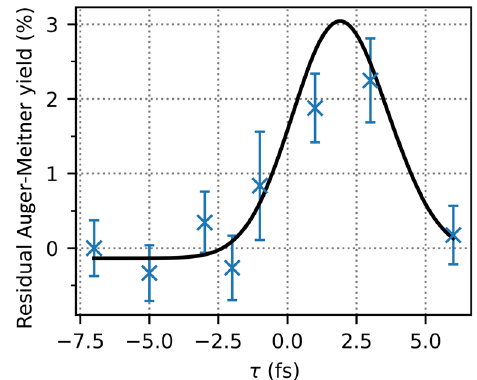
FIG. 4. Time dependence of excess Auger-Meitner electrons for a resonant probe, compared to a nonresonant probe. The signal is integrated over the region of peak flux, between binding energies of 17 and 25 eV, revealing a time-dependent resonant Auger-Meitner signal. A fitted exponential decay convolved with a Gaussian measurement response function is fitted by boot- strapping across time and energy bins (see the Appendix A) and is shown in black. This resonance, which maps the 6 a hole population, reveals a lifetime limited by the measurement response function of 1 (cid:2) 2